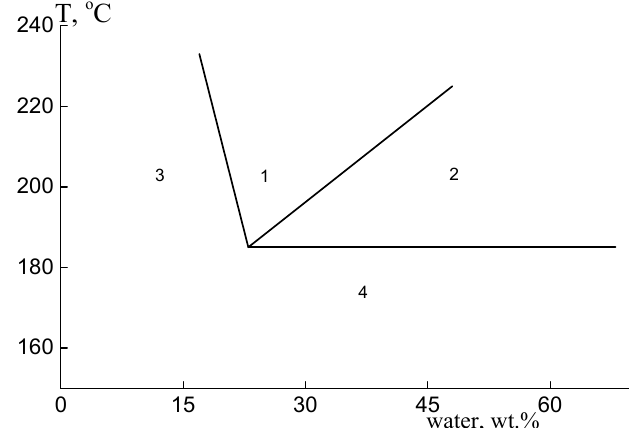
Figure 1. Phase diagram of PAN and water; modified from [96].